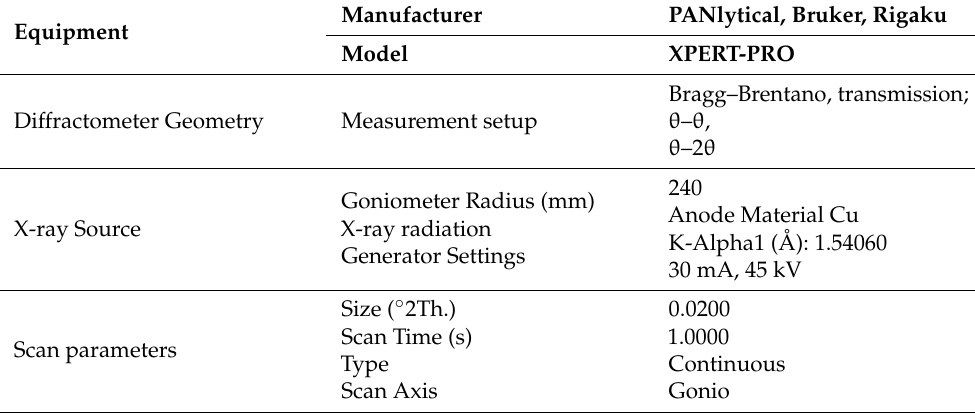
Table 8. X-ray diffraction data